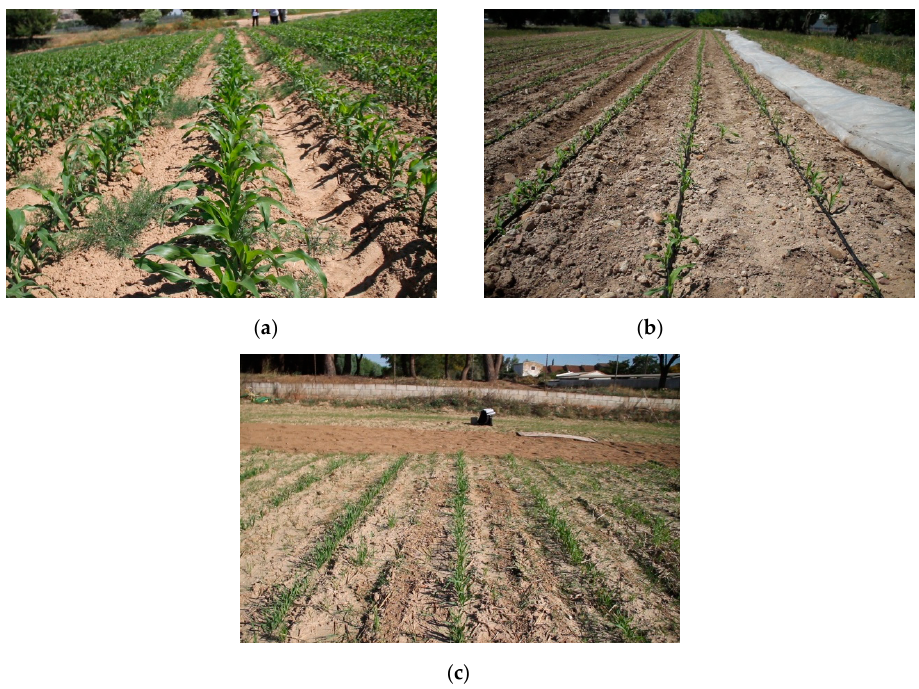
Figure 15. ( a ) – ( c ) are examples of different images that were acquired by the camera of the robot. ( a ) shows the maize crops; ( b ) shows the crop rows where the irrigation system used is visible; ( c ) shows the kind of image to be taken when a crop border is being reaching. Table 4. Detection of the central crop row. Performance of the proposed approach and an approach that is based on the Hough transform.